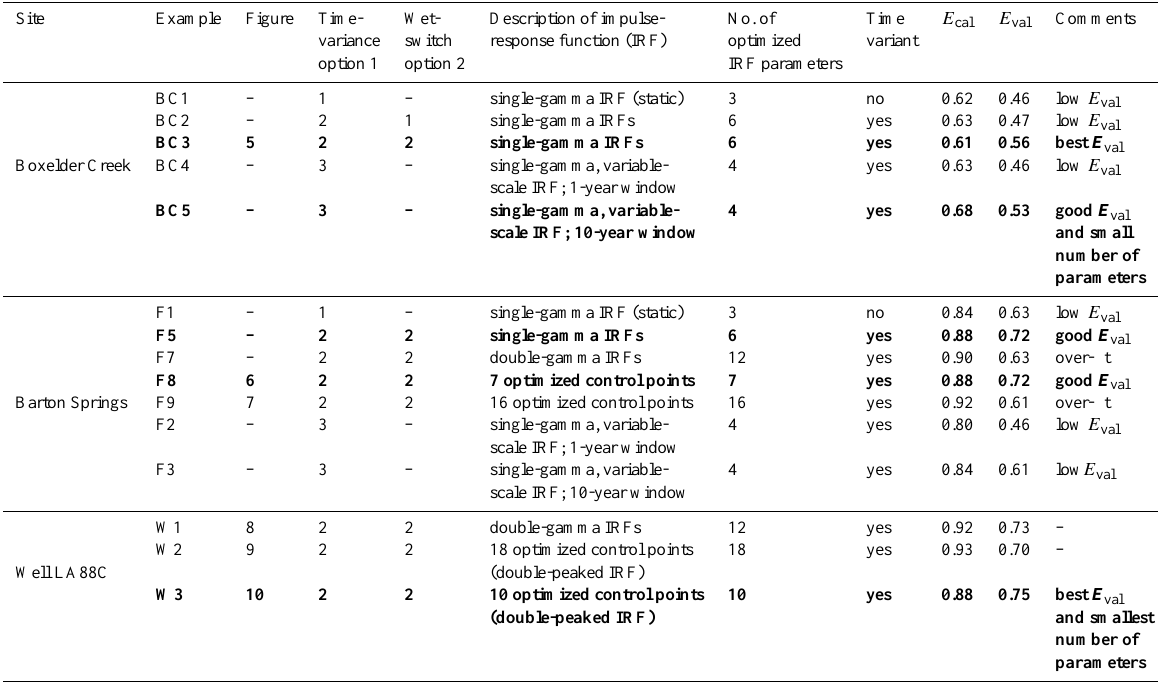
Figure 4. Example B3: observed (gray) and simulated (black) flow for Boxelder Creek. Table 2. Summary of example models. Rows in bold type indicate the best choices (– indicates not applicable). Site Example Figure Time-